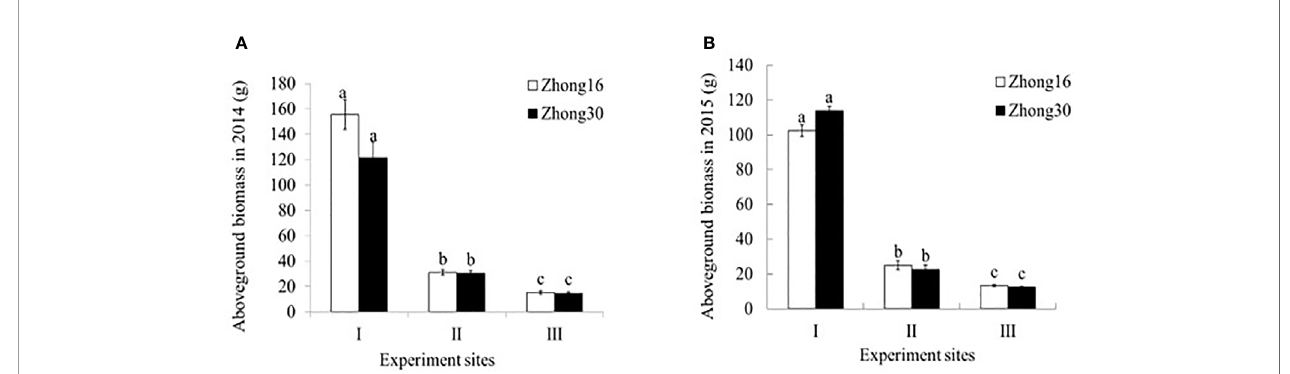
FIGURE 2 | Aboveground biomass (mean ± SEM) of Zhong30 and Zhong16 cotton plants grown under fi eld (I), grassland (II), and shrub (III) habitat in 2014 (A) and 2015 (B) . Data followed by the same lowercase letters are not signi fi cantly different at 0.05 level.